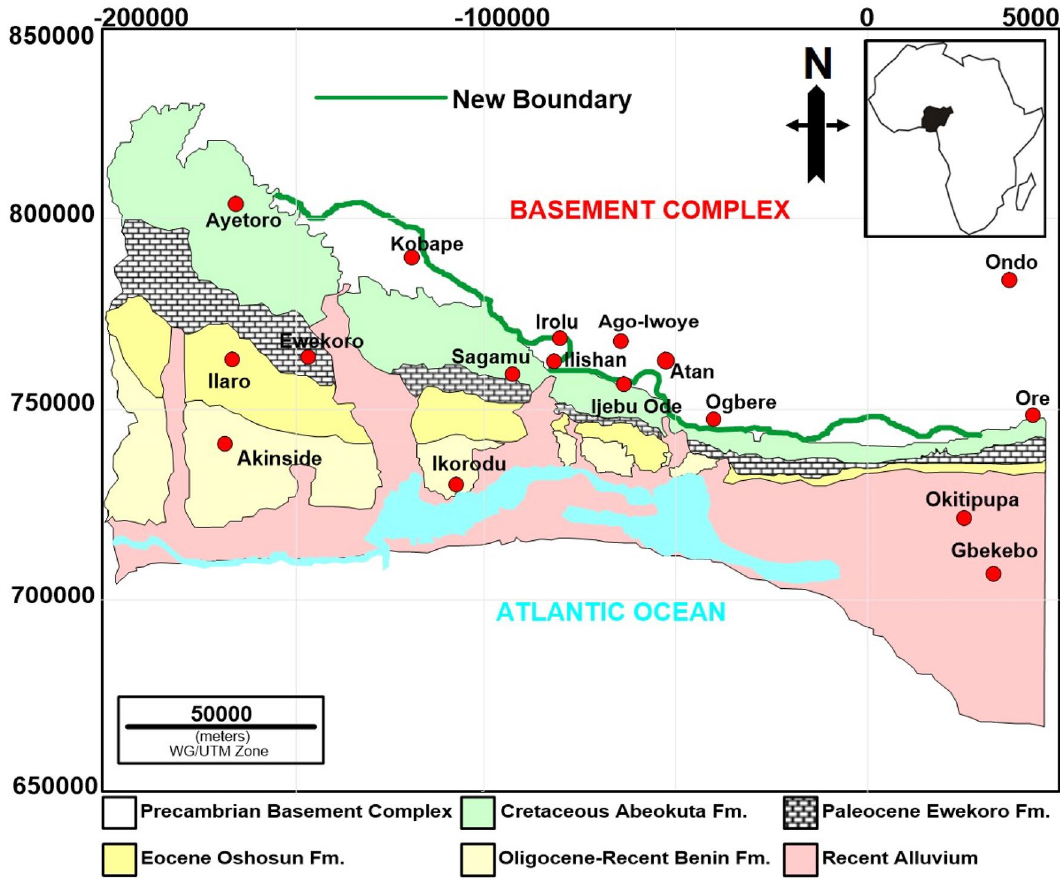
Figure 10. Geological map of the Eastern Dahomey Basin 36 showing the revised eastern boundary of the basin as defined from aeromagnetic tilt derivative boundary edge, ERT and VES interpretation. Note: The figure was drawn in CorelDRAW2017, https ://www.corel .com/en/ while the new boundary was taken from Figs. 3, 4 and